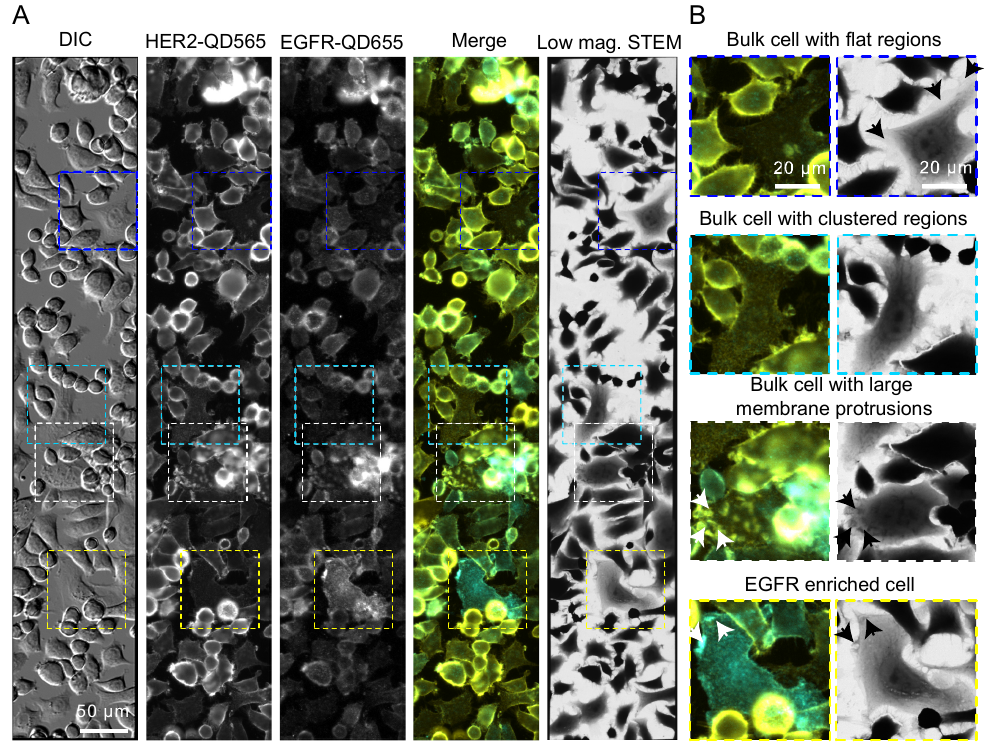
Figure 2. EGFR and HER2 dual labeling on SKBR3 cells. ( A ) Correlative fluorescence microscopy and low magnification bright field scanning transmission electron microscopy (STEM) of SKBR3 cells labeled for HER2-QD565 and EGFR-QD655. Light microscope images were acquired with a 20× objective and automatically stitched together. The same region is shown in the STEM image at a magnification (M) = 800×. Colored rectangles indicate the magnified areas depicted in ( B ) highlighting the identified cell surface regions and subtypes of cells for SKBR3: a bulk cell with flat appearing regions (blue frame, arrows), a bulk cell with clustered HER2 expression distributed over the surface of the cells (cyan frame), a bulk cell with large membrane protrusions (arrows), dorsal and lateral ruffles (white frame), and an EGFR enriched cell with clustered regions and large membrane protrusions (arrows) (yellow frame). Colors in the merged images: yellow for HER2 and cyan for EGFR. Scale bars: 50 µm ( A ) and 20 µm ( B ).